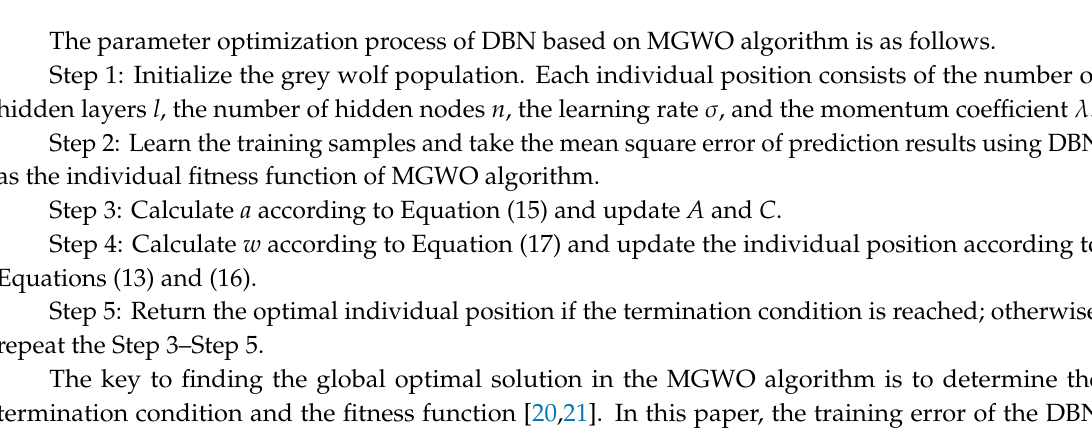
Figure 4. Modified grey wolf optimization (MGWO) algorithm-based optimization flow chart.